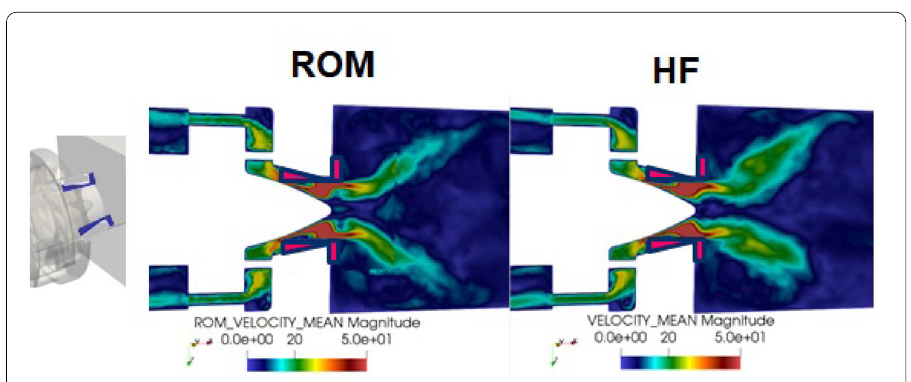
Fig. 35 The new geometrical mean velocity field for configuration 1